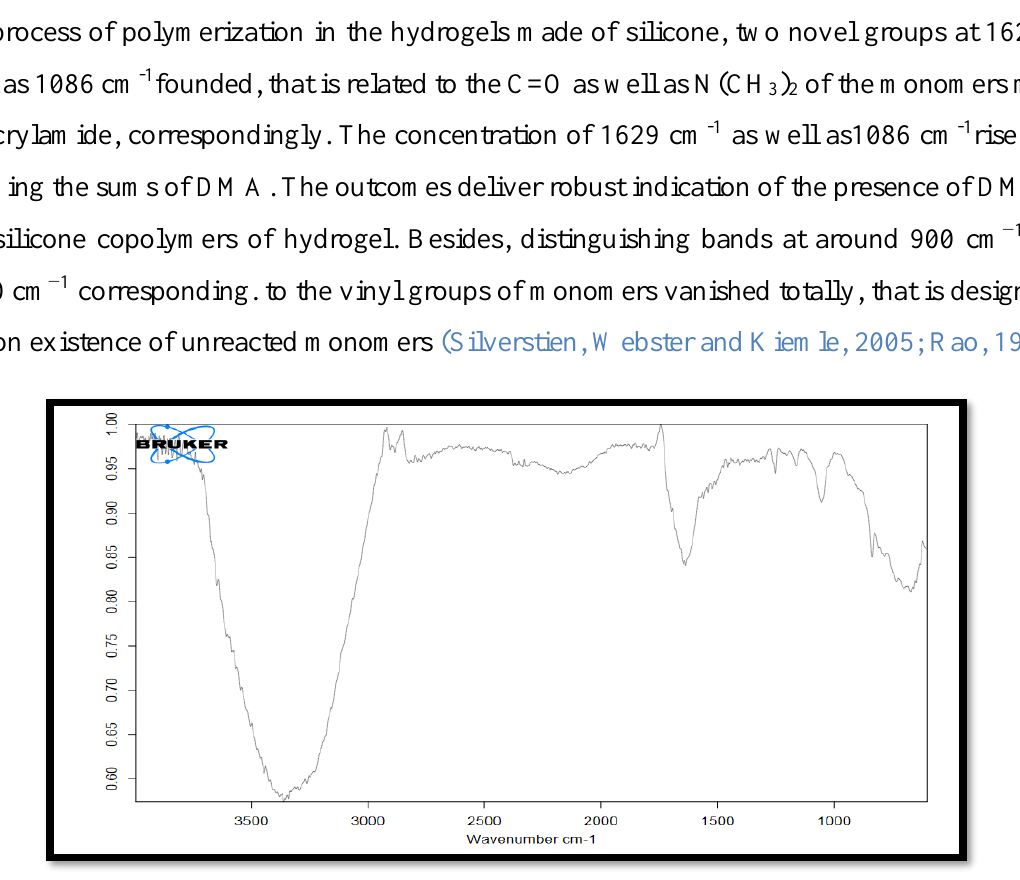
Fig. 9. FTIR spectra for